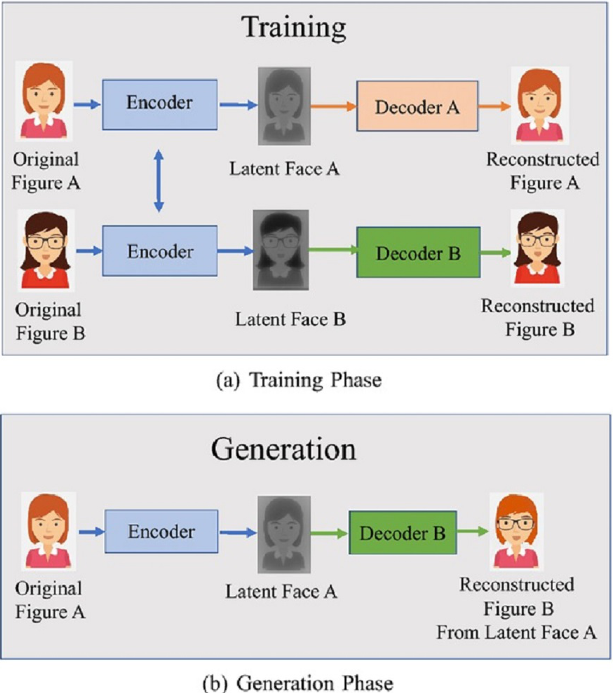
Figure 4. Deepfake generation process using encoder–decoder pair [40].